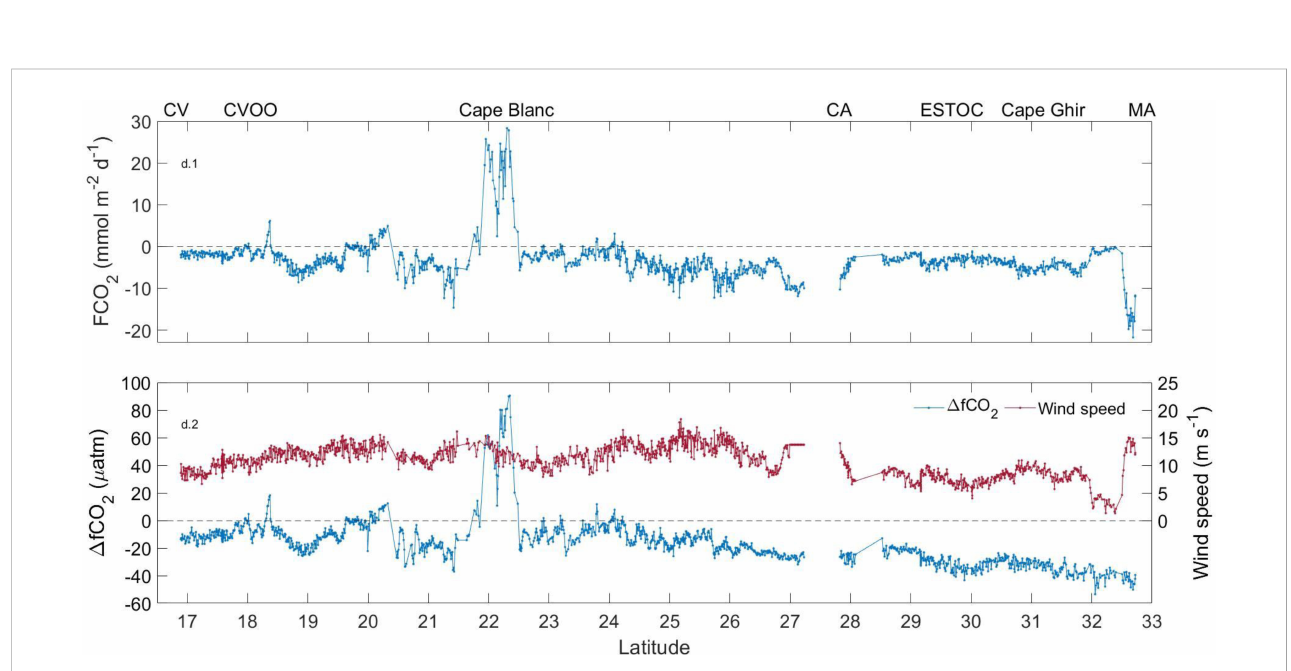
FIGURE 9 Latitudinal changes in FCO 2 , D fCO 2 and wind speed along the CV-CA-MA